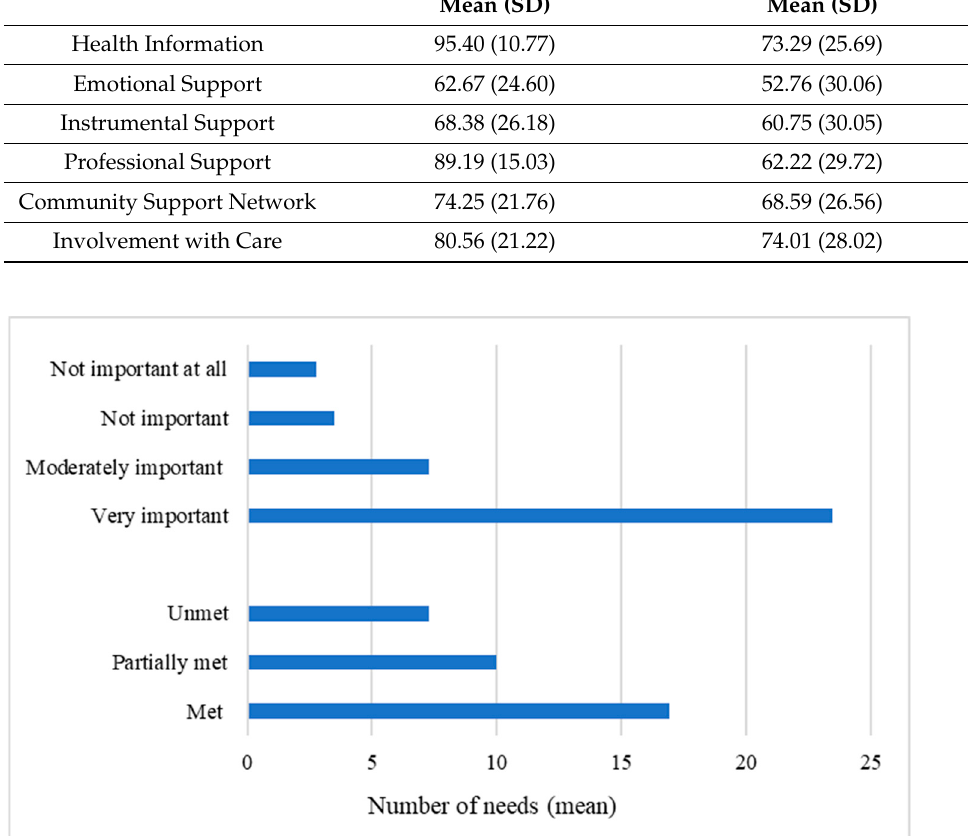
Table 3. Caregivers’ needs importance and satisfaction (FNQ).